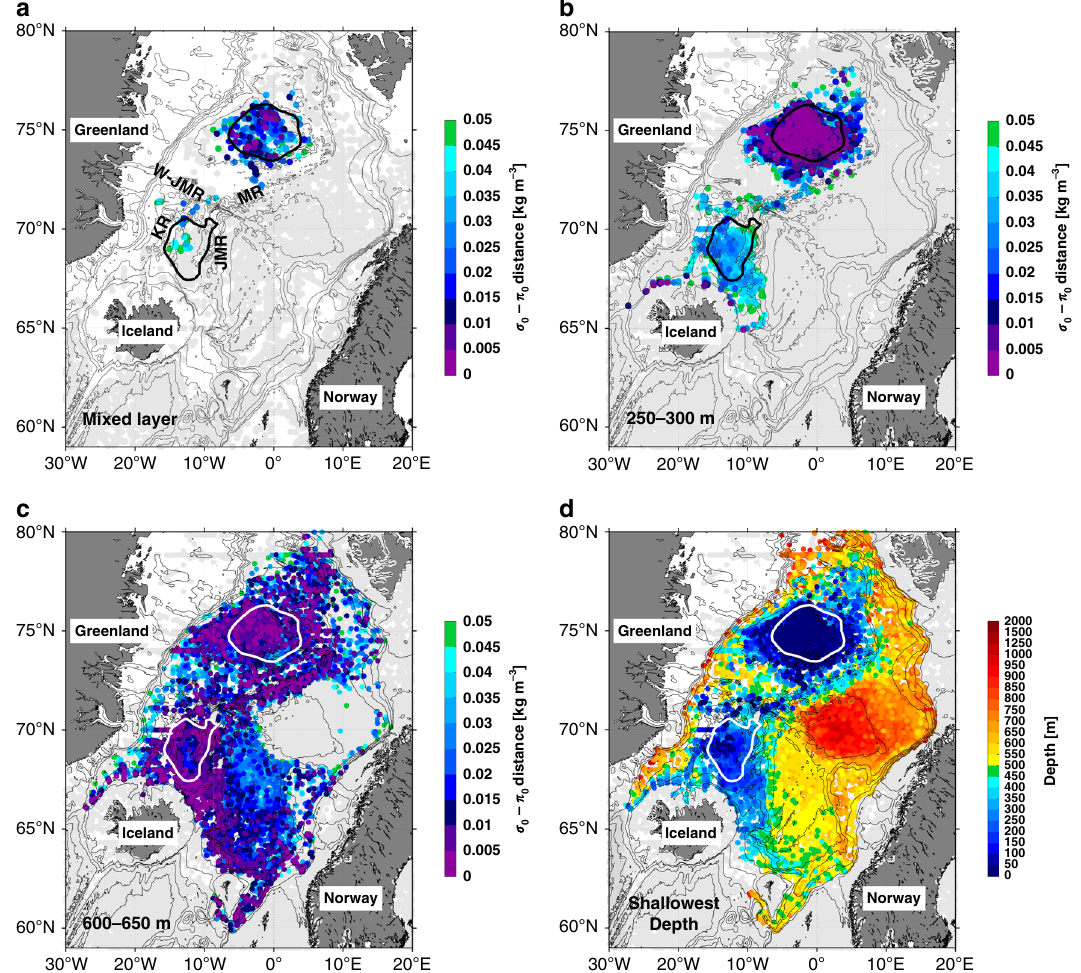
Fig. 2 Proximity in water mass space to the densest over fl ow water. a Distribution of the small potential density – potential spicity ( σ 0 – π 0 ) distances ( ≤ 0.05 kg m − 3 ) for late-winter (February – April) mixed layers from 2005 to 2015. Distances >0.05 kg m − 3 are shown by light-gray circles. The Greenland Sea and Iceland Sea gyres are delimited by the 4.5 and 7 dynamic cm contours, respectively, of sea surface dynamic height relative to 500 db (thick black and white contours). The thin gray contours show the bathymetry from ETOPO2, with four ridges labeled: MR, Mohn Ridge; W-JMR, West Jan Mayen Ridge; JMR, Jan Mayen Ridge; KR, Kolbeinsey Ridge. b , c The year-round distribution of small σ 0 – π 0 distances in the 250 – 300 m layer and 600 – 650 m layer, from 2005 to 2015. d The shallowest depth at which a small σ 0 – π 0 distance value (0.05 kg m − 3 ) is fi rst found in the vertical. Stations where this value is not attained are shown by light-gray